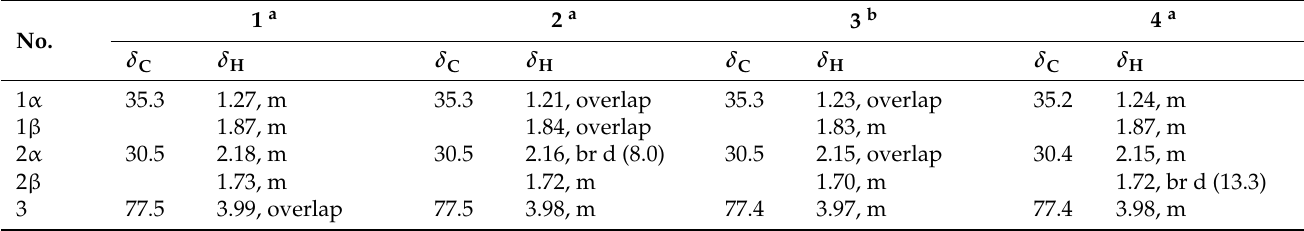
Table 1. 1 H (600 MHz) and 13 C NMR (150 MHz) data for compounds 1 – 4 ( δ in ppm, J in